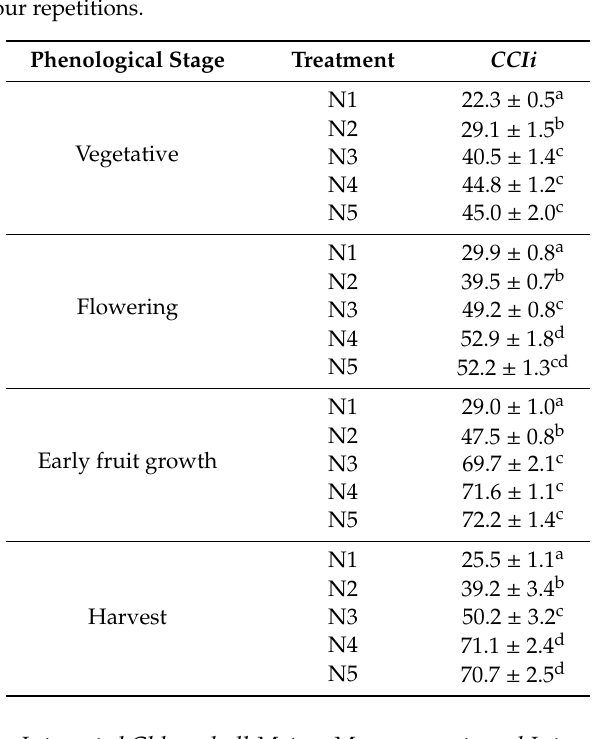
Table 5. Integrated CCI ( CCIi ) values for each N treatment within each phenological stage in the di ff erences between N treatments within each phenological stage, after LSD post-hoc test of ANOVA. p -value < 0.001. Values are means (n = 4) ± standard error (SE). The crop was subjected to five di ff erent N treatments with four